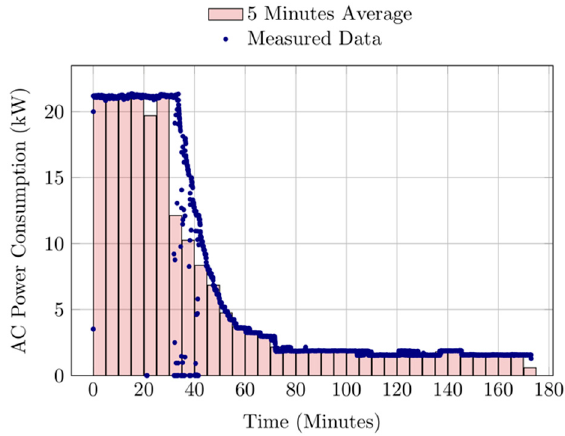
Figure 7. EV charging profile used as reference charging cycle in the simulations. EV: Electric Vehicle. A three-phase power meter UPM209 produced by Algodue Elettronica s.r.l. (Maggiora, Italy),